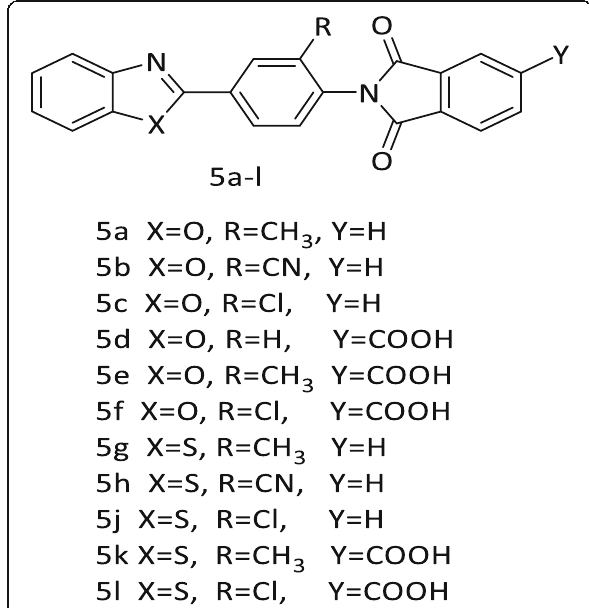
Fig. 35 Benoxazole/benimidazole phthalimide-based compounds